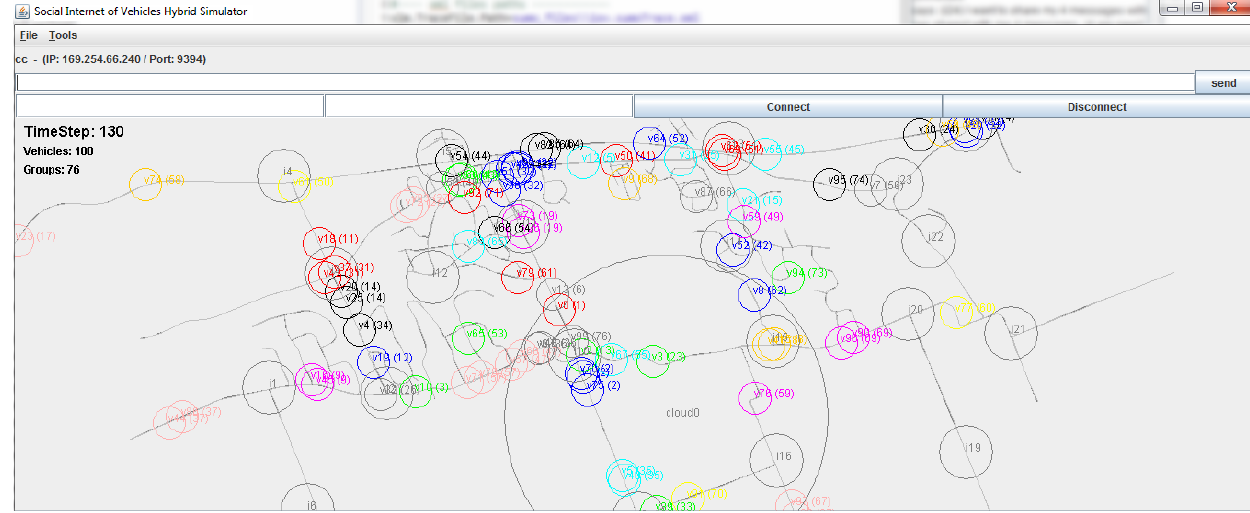
Figure 10. In this simulation window, we present 100 simulated vehicles, 25 infrastructures and 1 social graph cloud on the Cumberland, Ottawa, Canada region. In this picture, i(x) represents infrastructure process, v(x) represents vehicle process, cloud0 represents social cloud process, and same colored v(x) vehicles are connected in a platoon as